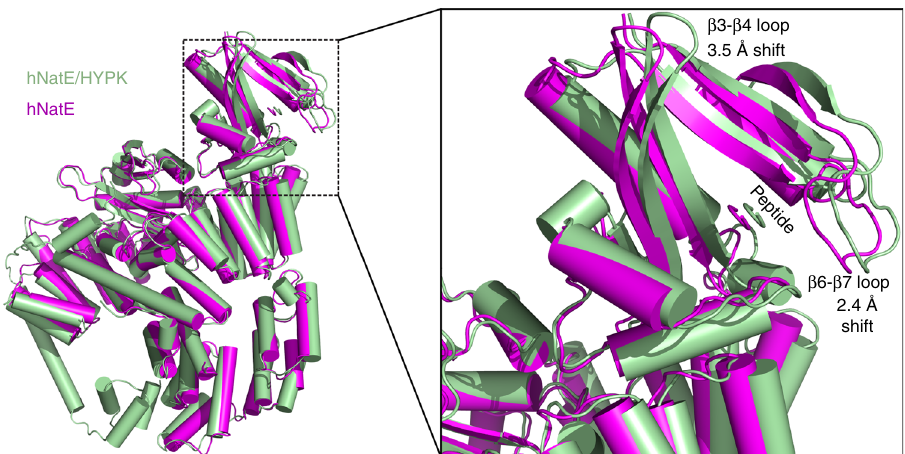
Fig. 8 Molecular basis for the decrease of hNAA50 activity by HYPK. hNatE/HYPK (green) overlayed onto hNatE (magenta) with hNatA aligned. Zoom- in view shows the local conformational change